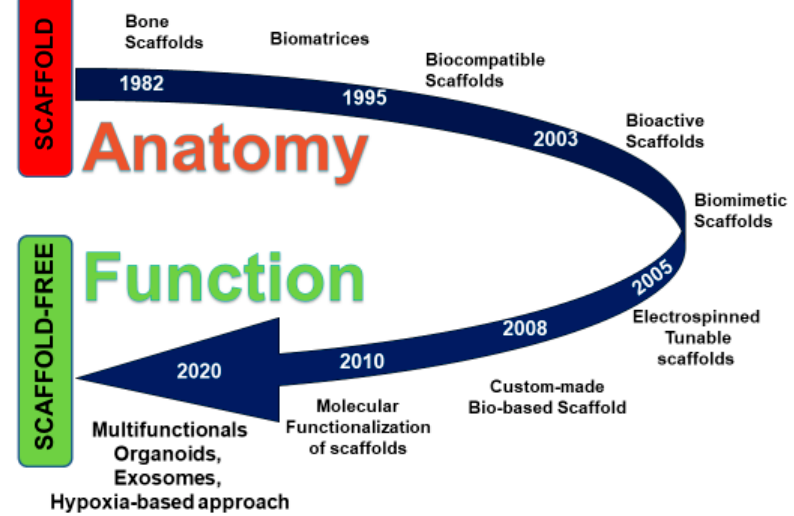
Figure 1. Time-dependent scheme representing the evolution of scaffold-based approaches and the recent development of scaffold-free methodologies.